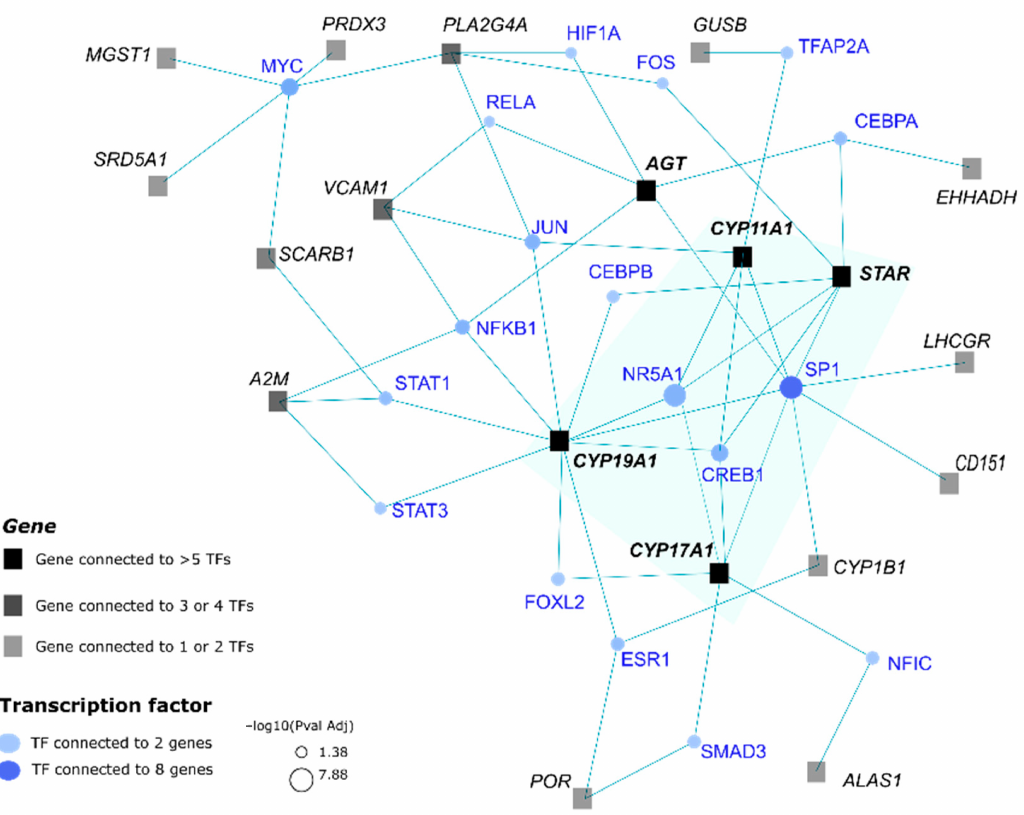
Figure 8. Possible regulation network of genes from the CYP11A1-group. Transcription factors (in blue) that may contribute to the regulation of genes (in black) from the CYP11A1-group were identified using human orthologous genes. The core (highlighted in a blue-green background) of this network included four genes and three